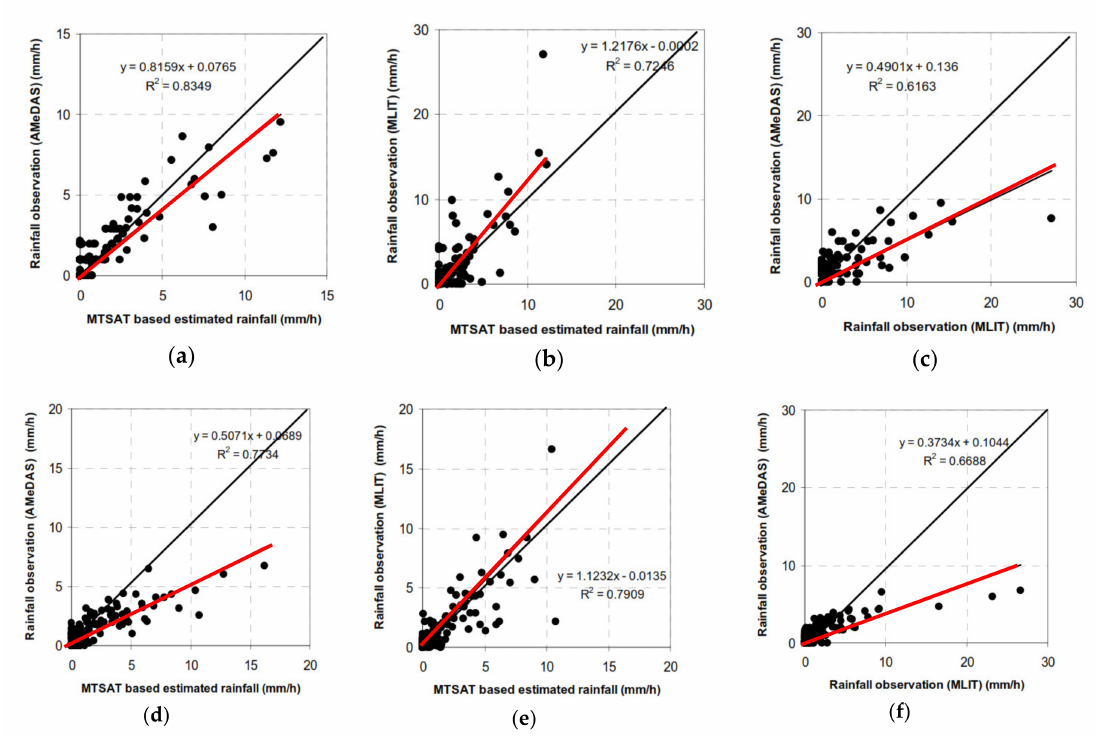
Figure 5. Scatter plot of catchment average hourly rainfall; ( a , d ) MTSAT based rainfall estimation vs. observed rainfall by AMeDAS, ( b , e ) MTSAT based rainfall estimation vs. observed rainfall by MLIT, and ( c , f ) observed rainfall by AMeDAS vs. observed rainfall by MLIT from August 2010 for ( a – c ) Shirai river catchment and ( d – f ) Bebetsugawa river